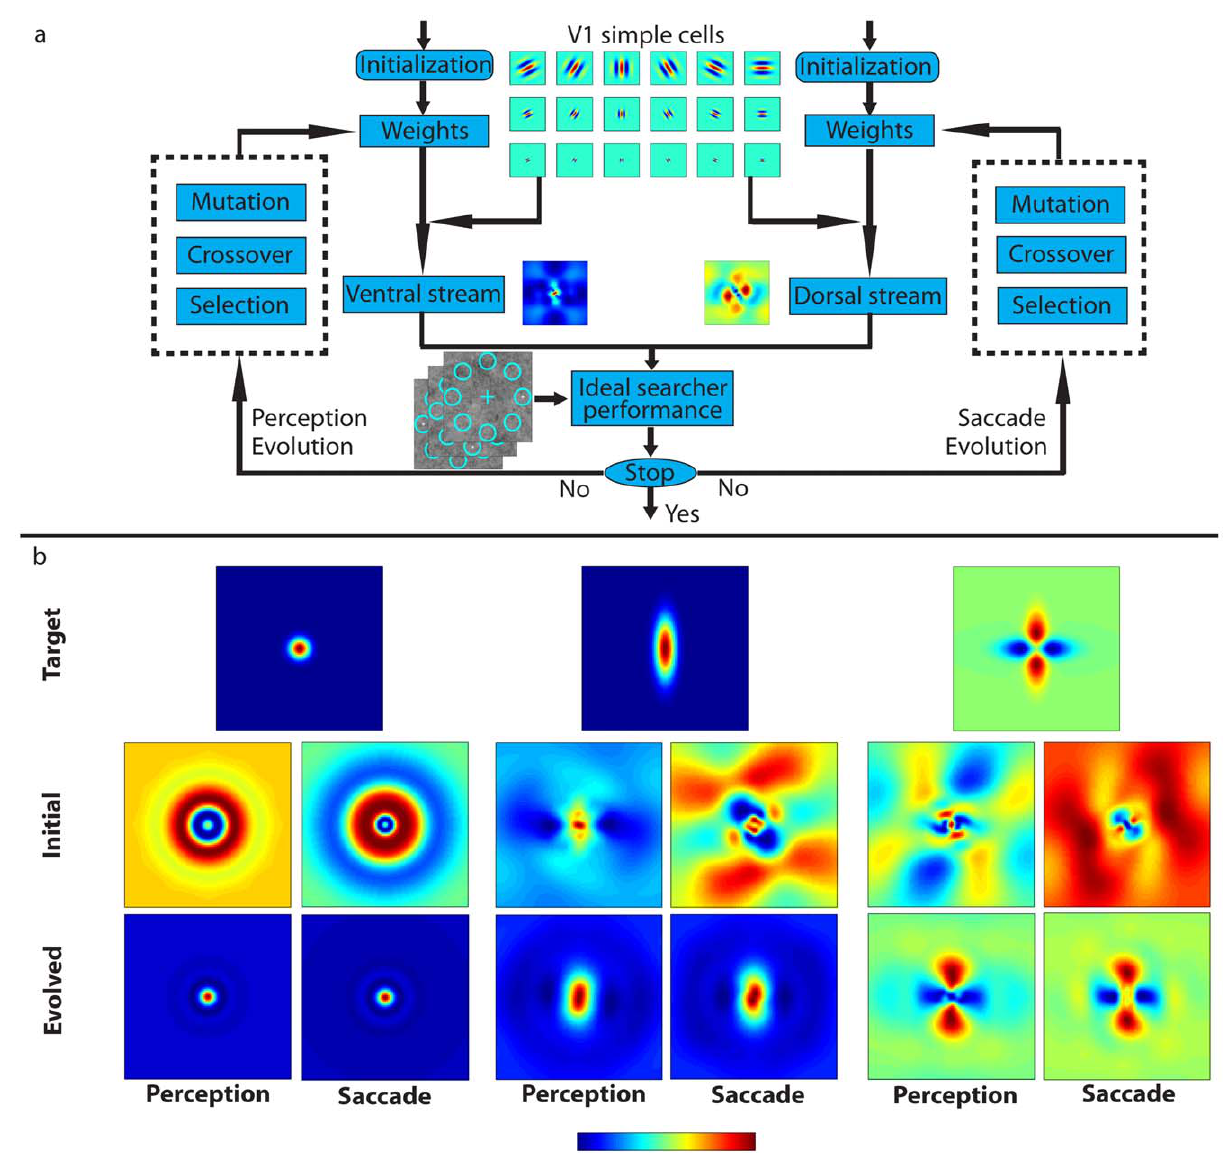
Figure 2. Virtual evolution of two separate streams with the genetic algorithms for three different targets. a. Virtual evolution of the perception (ventral stream) and saccade (dorsal stream) templates constructed from different linear combinations of twenty four different V1 simple cells which spanned the target (Gabor functions with center frequencies, 0.5, 1, 2, 4 cycles/degree for 6 different orientations, 30 degrees apart, and octave bandwidths). Probability of survival of an individual depends on search accuracy of the ideal searcher approximation (ELM model) with the two templates. b. Top row three different targets (from right to left: isotropic Gaussian, vertical elongated Gaussian and the difference of a vertical and horizontal elongated Gaussians) used in different evolution simulations for search in 1/f noise and a steep visibility map (See Figure 1c, left). All targets are luminance grey patterns but are shown in pseudo-color and scaled for each image to maximize the use of the color scale.